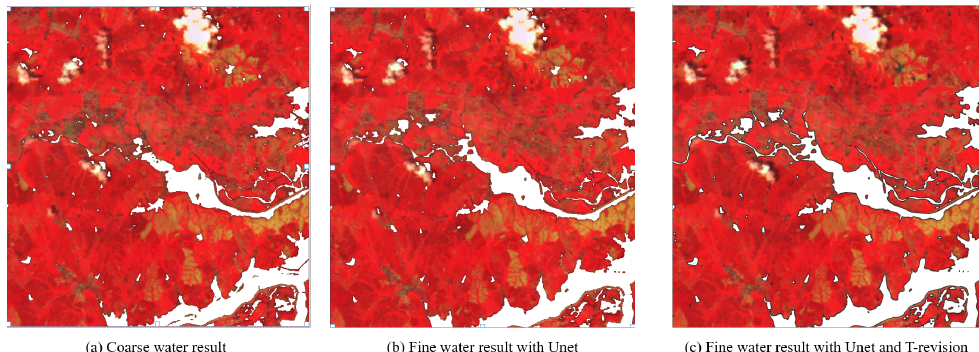
Figure 13. Fine water extraction of Zhuhai hyperspectral.